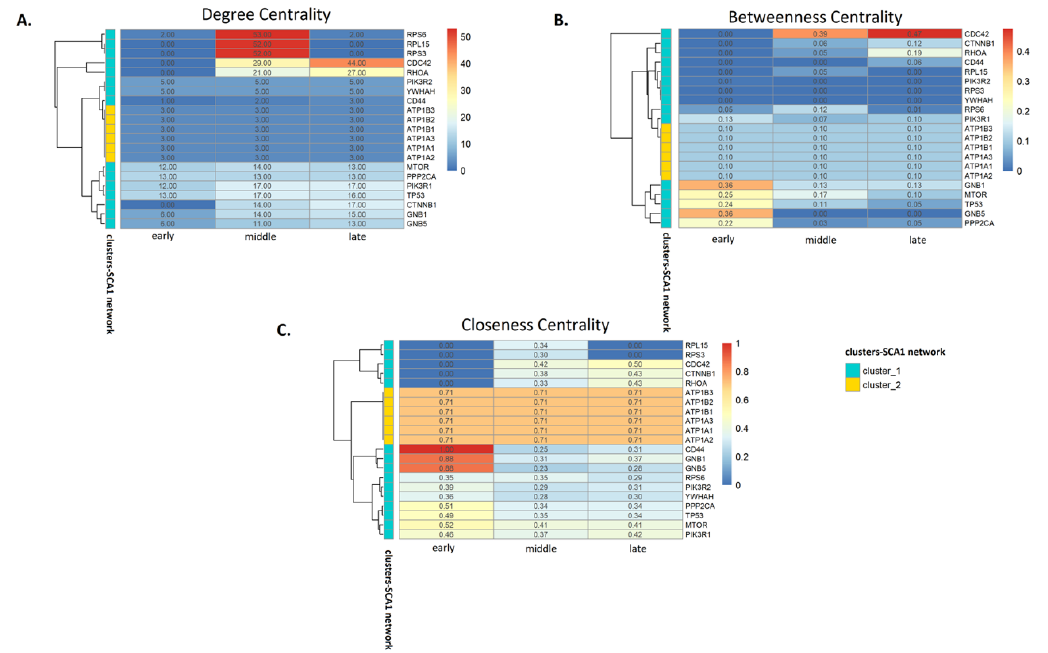
Figure 3. Centrality heatmaps of 21 nodes of the SCA1 disease network with the higher DC, BC and CC values per time-point. ( A ). Degree, ( B ). betweenness and ( C ). closeness centralities at early, middle or late time-point of protein aggregation. ( B ). Color range from blue (low) to red (high) indicates scaled centrality values. Chromatic code on the left side of each heatmap indicates in which cluster of the SCA1 network each node belongs.